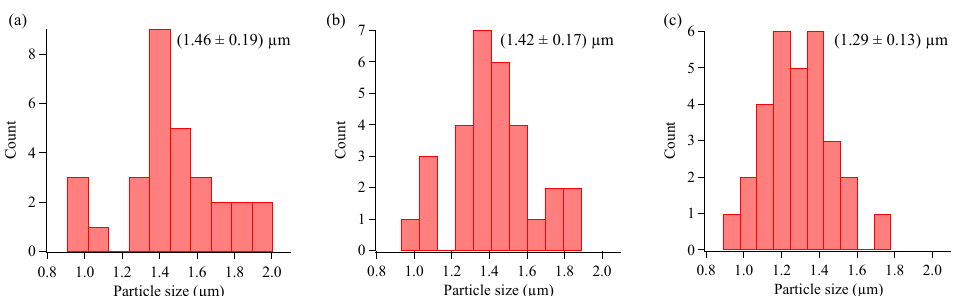
Figure 6. Size distribution of particles prepared with different concentrations of Cu nitrate: ( a ) 0.1, ( b ) 1, and ( c ) 10 mM.